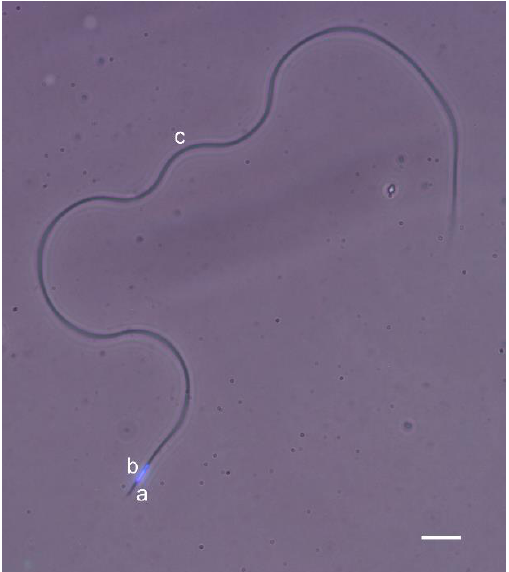
Figure 1. A combined phase-contrast and fluorescence (Hoechst) image of a honey bee spermatozoon showing the acrosome (a), nucleus (b) and flagellum (c). Scale-bar = 10 µm.